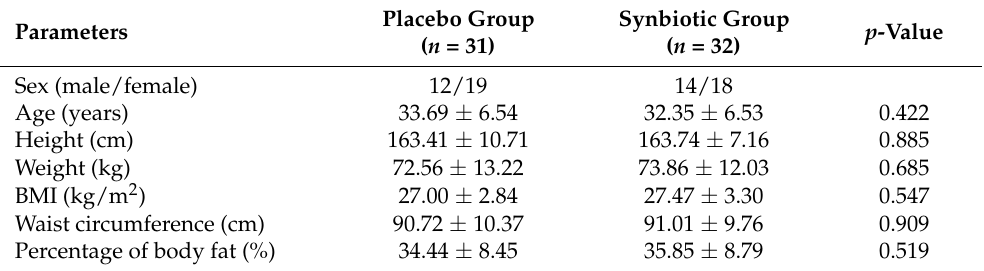
Table 1. Baseline characteristics of the participants.